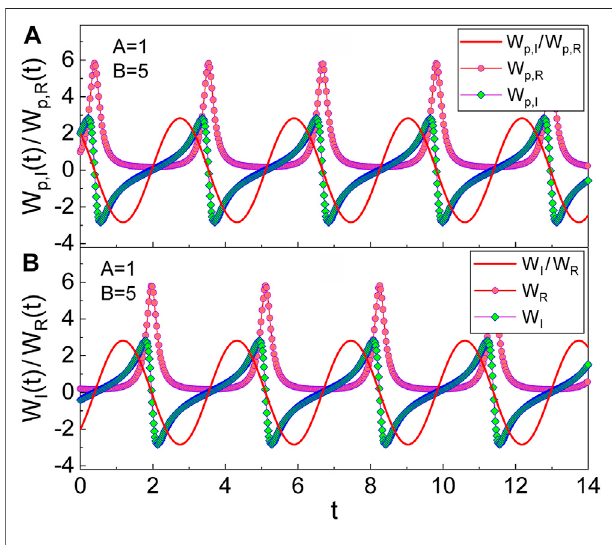
FIGURE 2 | (A) is the evolution of W p ,I / W p ,R and its components W p ,R and W p ,I , relevant to p -space, with the choice of A (cid:1) 1, B (cid:1) 5, and C (cid:1) 2. (B) is the evolution of W I / W R and its components relevant to q -space (comparison purpose).Thevaluesthatwehavetakenare ω (cid:1) 1, Z (cid:1) 1, ϵ (cid:1) 1, t 0 (cid:1) 0,and φ (cid:1)